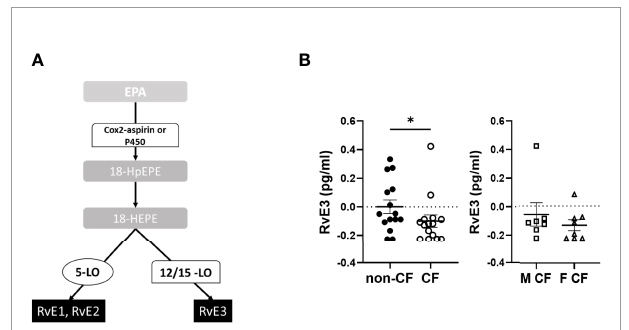
FIGURE 4 | Eicosapentaenoic acid metabolism (EPA) metabolites biosynthesis. (A) Schematic illustration of the E-series of resolvins (RvE) biosynthesis ’ pathway showing the enzymes involved, 5-LO, 15-LO, 12-LO and their intermediates substrates, the 18-hydroxyeicosapentaenoic acid (18HEPE). (B) Comparison of the mean levels of the EPA metabolite RvE3 between samples derived from non-CF and CF subjects (left) and from male and female CF patients (right). (Mann-Whitney test.